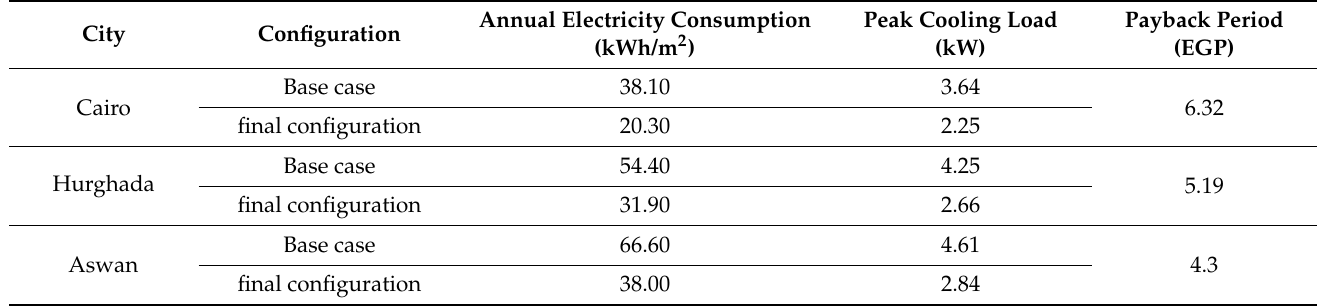
Table 9. The reduction in annual electricity consumption and peak cooling loads applying the best alternatives and reduced